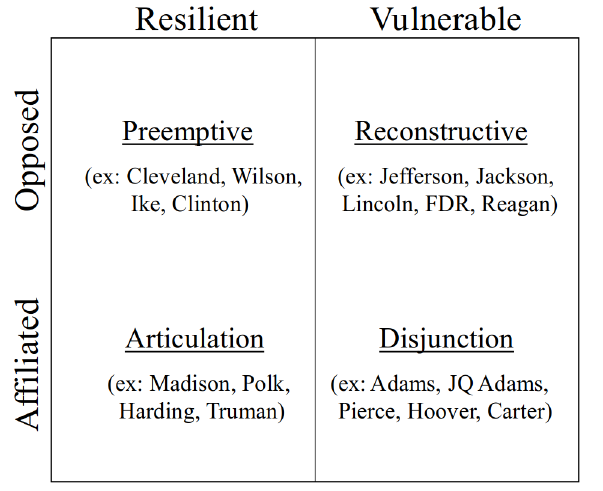
Figure 1. Skowronek’s Political Time